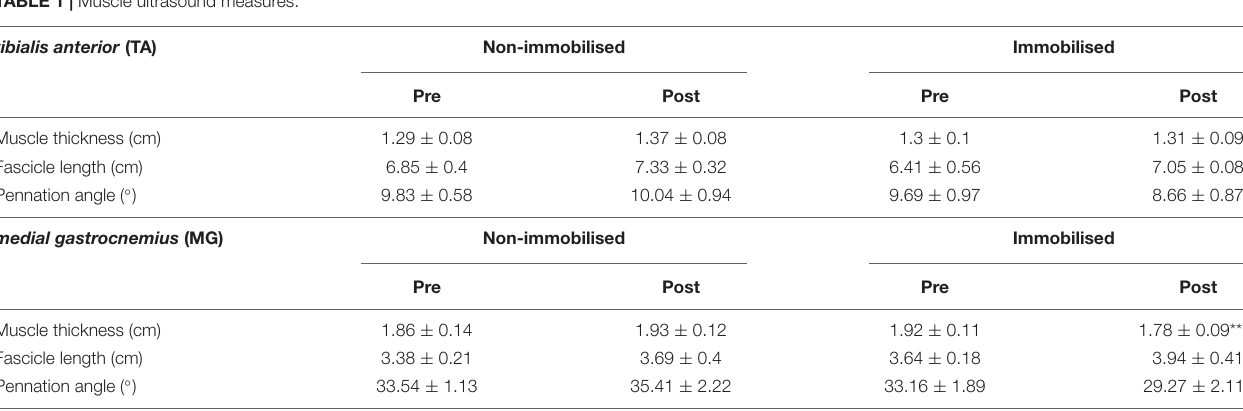
FIGURE 5 | Representative muscle thickness ultrasound image of (A) tibialis anterior (TA) and (B) medial gastrocnemius (MG). Pre and post 15-day unilateral leg immobilisation TA (C) and MG (D) muscle thickness in non-immobilised and immobilised legs. Muscle thickness changes compared to baseline values in in TA (E) and MG (F) . Mean values are denoted as + , with box margins the 25th and 75th percentile and whiskers min to max values. ** p < 0 . 01 between indicated groups. Pre and post analysis measured by 2-way ANOVA, percentage change by paired t test. TABLE 1 | Muscle ultrasound